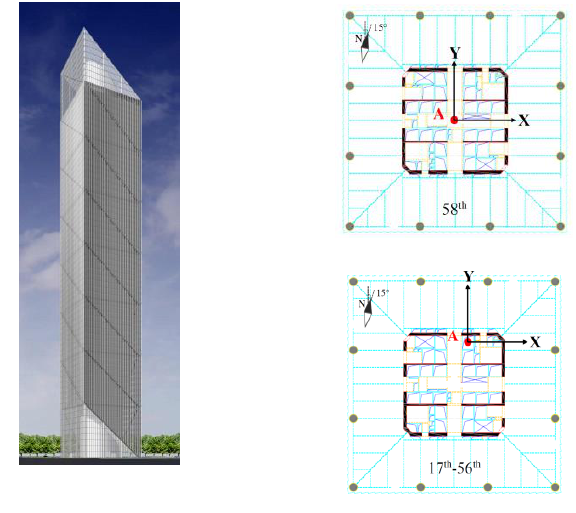
Figure 1. Overview of the Leatop Plaza.